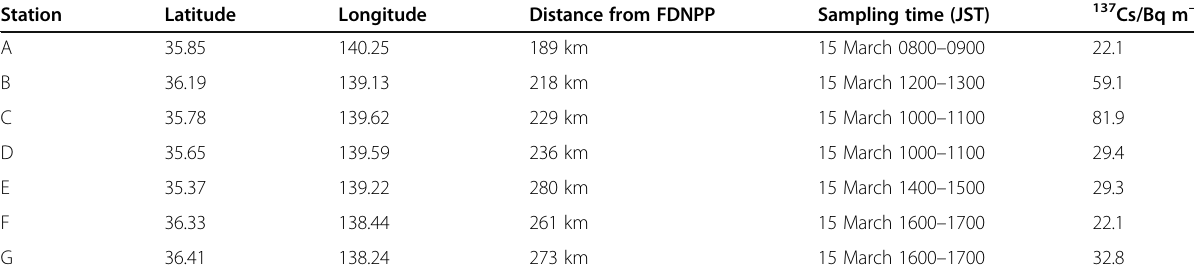
Table 1 Information of seven monitoring stations (A~G) and SPM filter-tape samples investigated in the present study Station Latitude